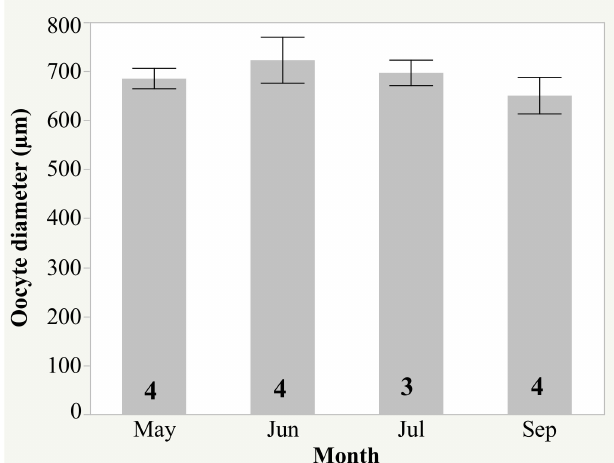
Figure 3. Mean ( ± Standard Error of the Mean, SEM) oocyte diameter of F1 greater amberjack ( n inside the bars) that were expected to respond to given GnRHa implant, at the time of treatment (May–July) and at the conclusion of the experiment (September). No statistically significant differences were observed ( p <